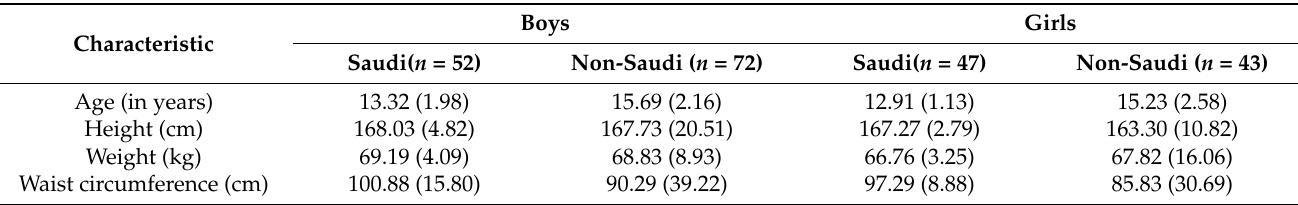
Table 1. Gender based demographic and anthropometric characteristics of the Saudi (46%, n = 99) and non-Saudi (54%, n = 115)